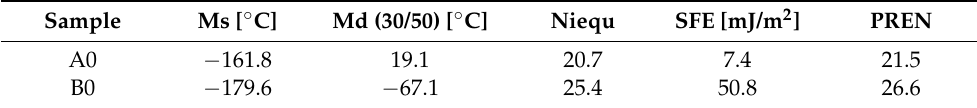
Table 4. Comparative parameters of the mechanical stability and pitting corrosion of the A0 and B0 samples.